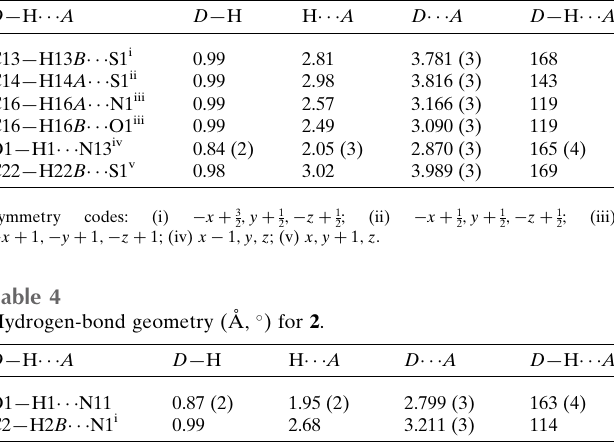
(Fig. 4). There are additional C—H (cid:2) (cid:2) (cid:2) N and C—H (cid:2) (cid:2) (cid:2) O contacts but from the distances and angles it is indicated that these are very weak interactions (Table 3).